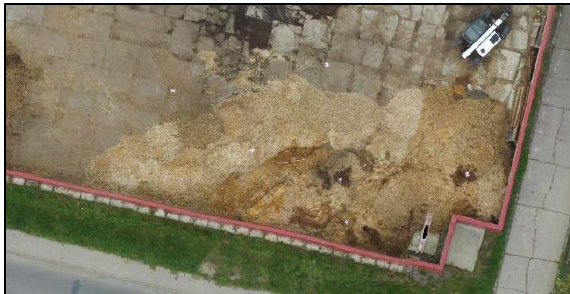
Figure 1. The wood chips pile orthomosaic example